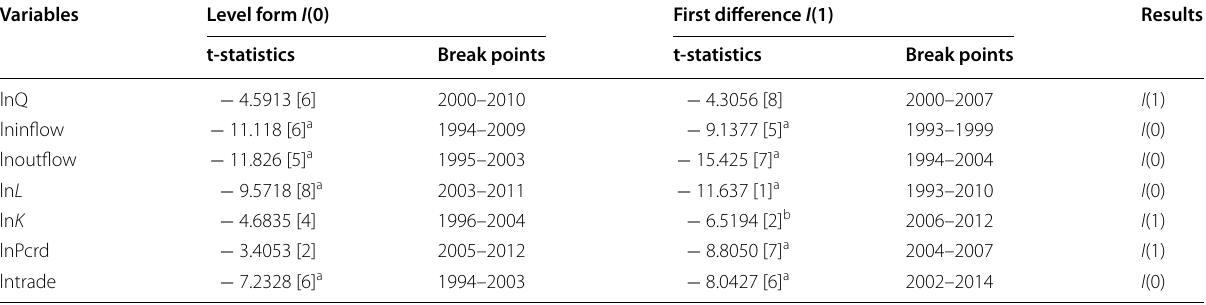
a,b Indicate 1% and 5% level of significance